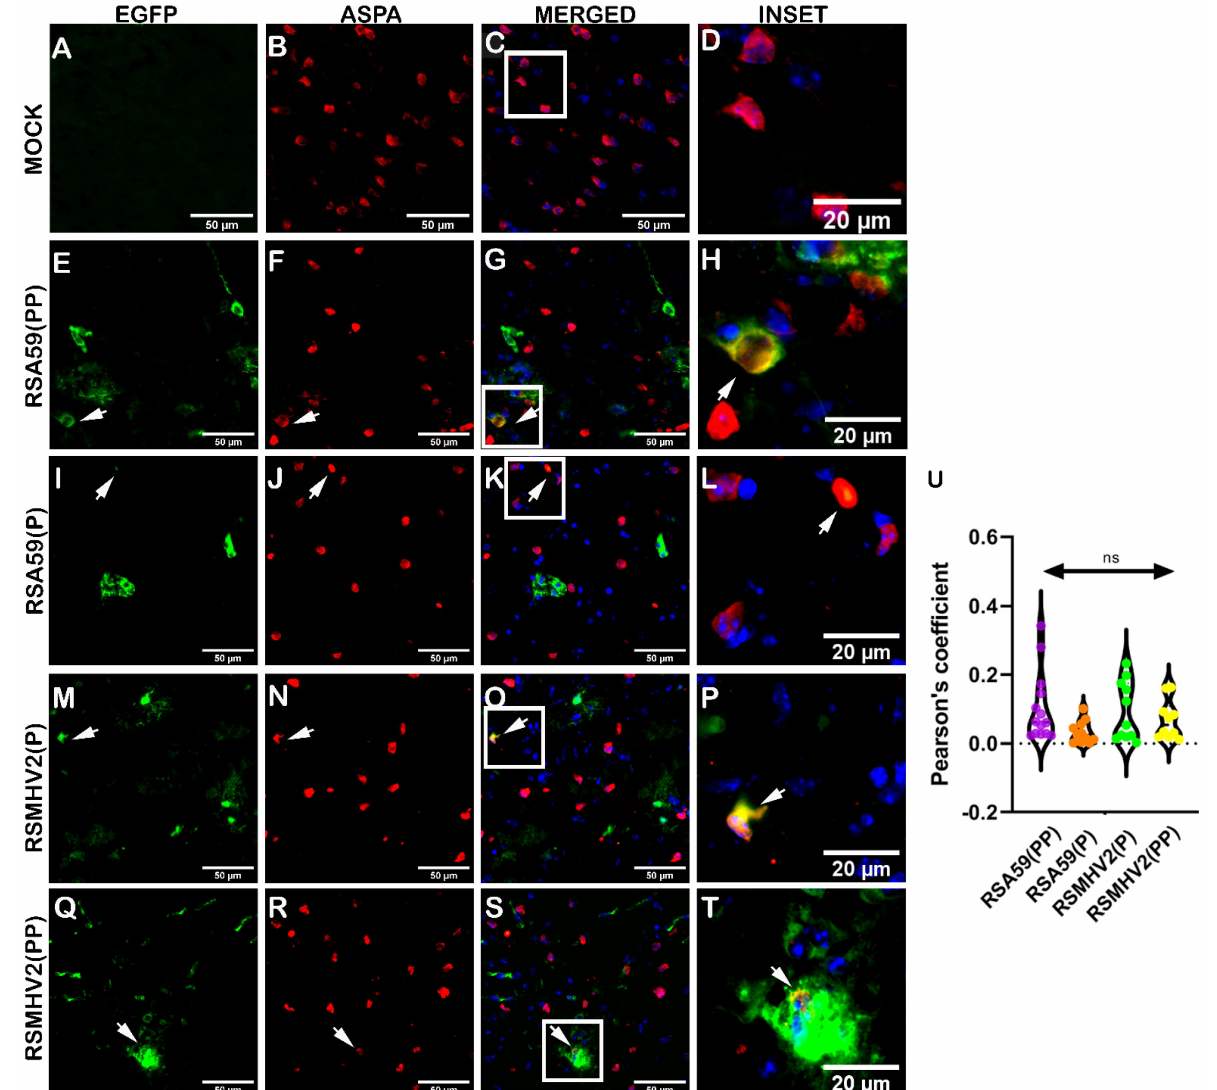
Figure 8. Colocalization of two proline containing strains RSA59(PP), RSMHV2(PP), single proline containing strains RSA59(P) and RSMHV2(P), infection within oligodendrocytes in the brain of mice at day 5 p.i. Cryosections of infected mouse brains and mock-infected mice were immunofluorescently labeled with ASPA ( B , F , J , N , R ). EGFP indicated infected cells in panels ( E , I , M , Q ), and a mock infected brain is shown in panel ( A ). Images of EGFP and ASPA were merged and DAPI counterstained ( C , G , K , O , S ) and show colocalization of EGFP and ASPA-positive cells with arrowheads highlighting virus infected oligodendrocytes. Infected brain sections from RSA59(PP), RSA59(P), RSMHV2(P), and RSMHV2(PP) are shown in Panels ( E – H , I – L , M – P , Q – T ), respectively. The insets highlighted by a white rectangle in the merged panels shows the area magnified view to show colocalization of oligo- dendrocytes with EGFP ( D , H , L , P , T ). The percentage of infected oligodendrocytes was determined and plotted in a violin diagram ( U ). The One-way ANOVA was used to compare RSA59(PP) with RSA59(P), RSMHV2(P), RSMHV2(PP) and RSMHV2(P) with RSMHV2(PP). The level of significance was taken at p < 0.05. ns denotes